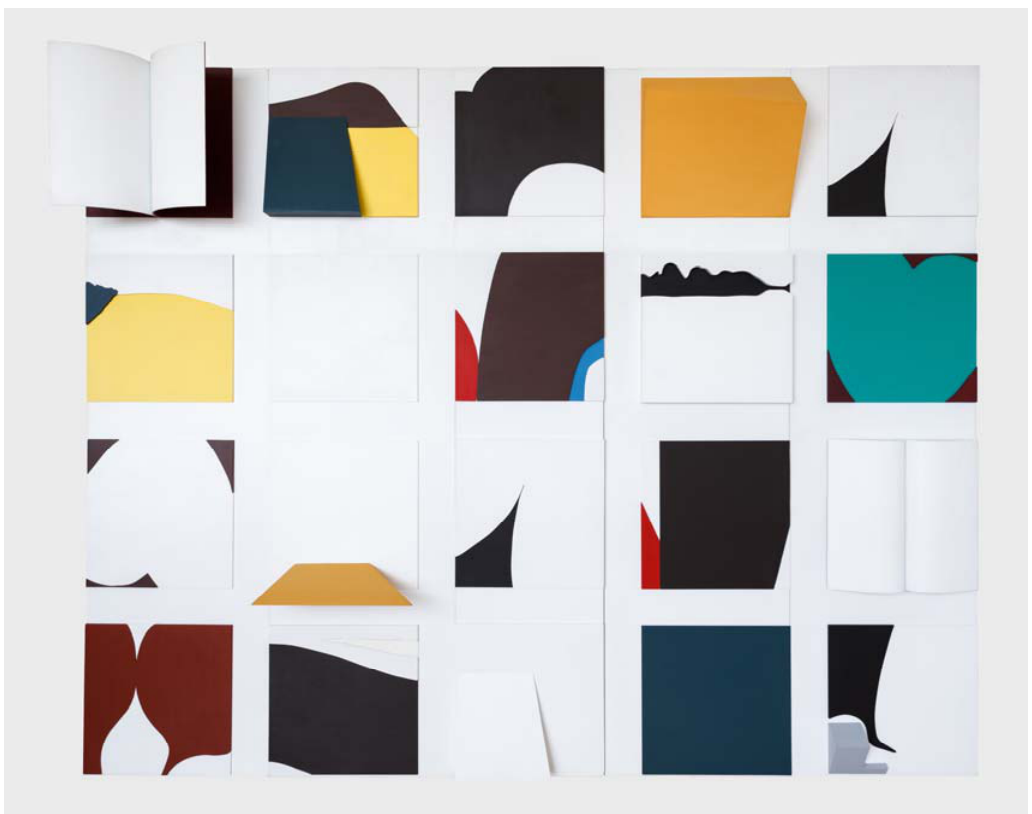
Figure 1. Ernest Edmonds, Nineteen (1968–69).